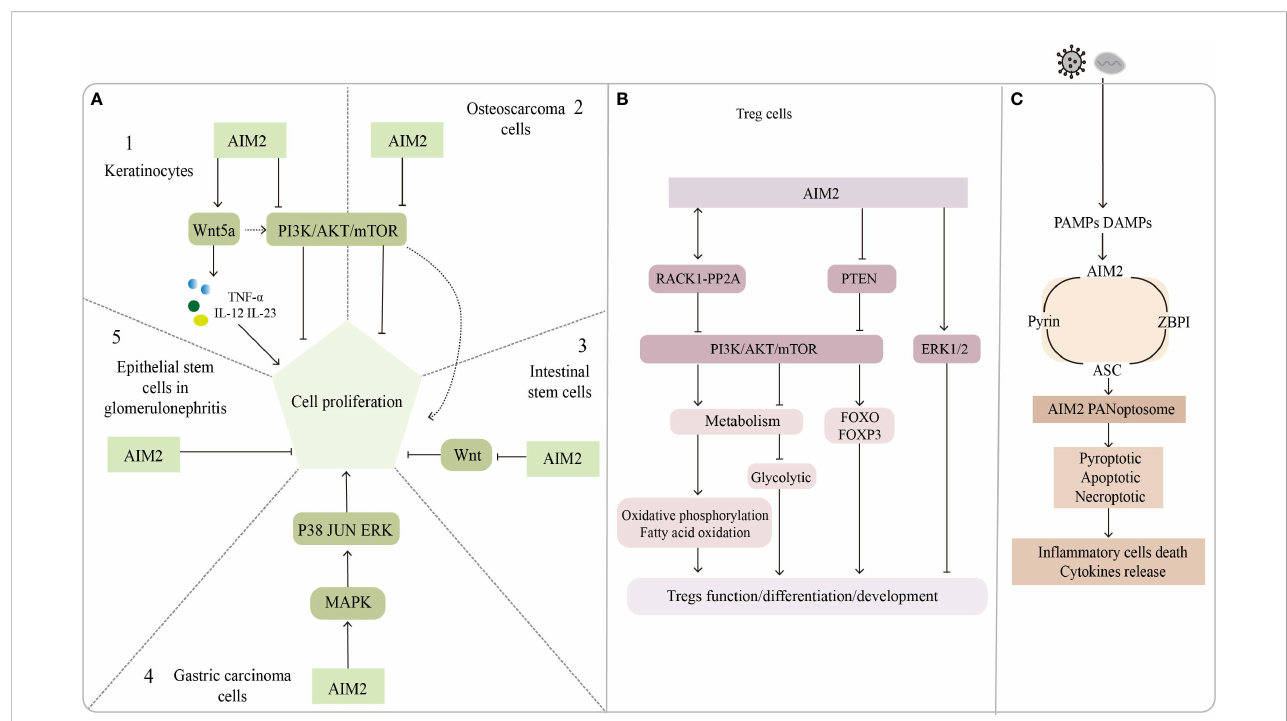
FIGURE 2 The in fl ammasome-independent way of AIM2. (A) Regulatory role of AIM2 in cell proliferation. A1, A2: AIM2 promotes keratinocytes proliferation through the Wnt5a pathway; PI3K/AKT pathway promotes keratinocytes and osteosarcoma cells proliferation, but AIM2 inhibits it. A3: AIM2 inhibits the proliferation of intestinal stem cells by suppressing the Wnt pathway, AIM2 activates PI3K/AKT pathway via Wnt5a and promotes intestinal stem cell proliferation. A4: AIM2 promotes gastric carcinoma cell proliferation through MAPK pathway. A5: AIM2 put a curb on epithelial stem cells proliferation in glomerulonephritis. (B) Role of AIM2 in Treg cells function/development/differentiation. AIM2 interacts with RACK1-PP2A protein to inhibit AKT/mTOR pathway, leading to metabolite changes that regulate Treg function and stability; AIM2 inhibits Treg proliferation through ERK1/2 pathway or by inhibiting PI3K/AKT pathway. (C) AIM2 forms a complex named AIM2 PANoptosome with pyrin, ASC and ZBPI, which mediates in fl ammatory cell death and cytokine